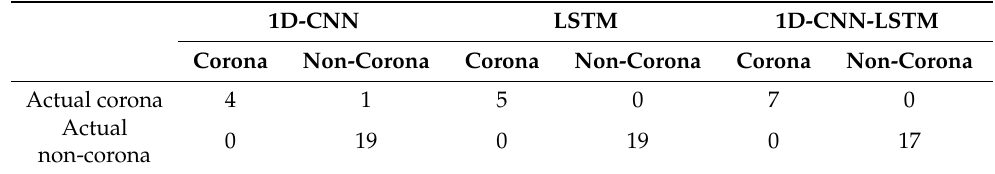
Table 12. Frequency domain corona fault classification output matrix for testing the phase.